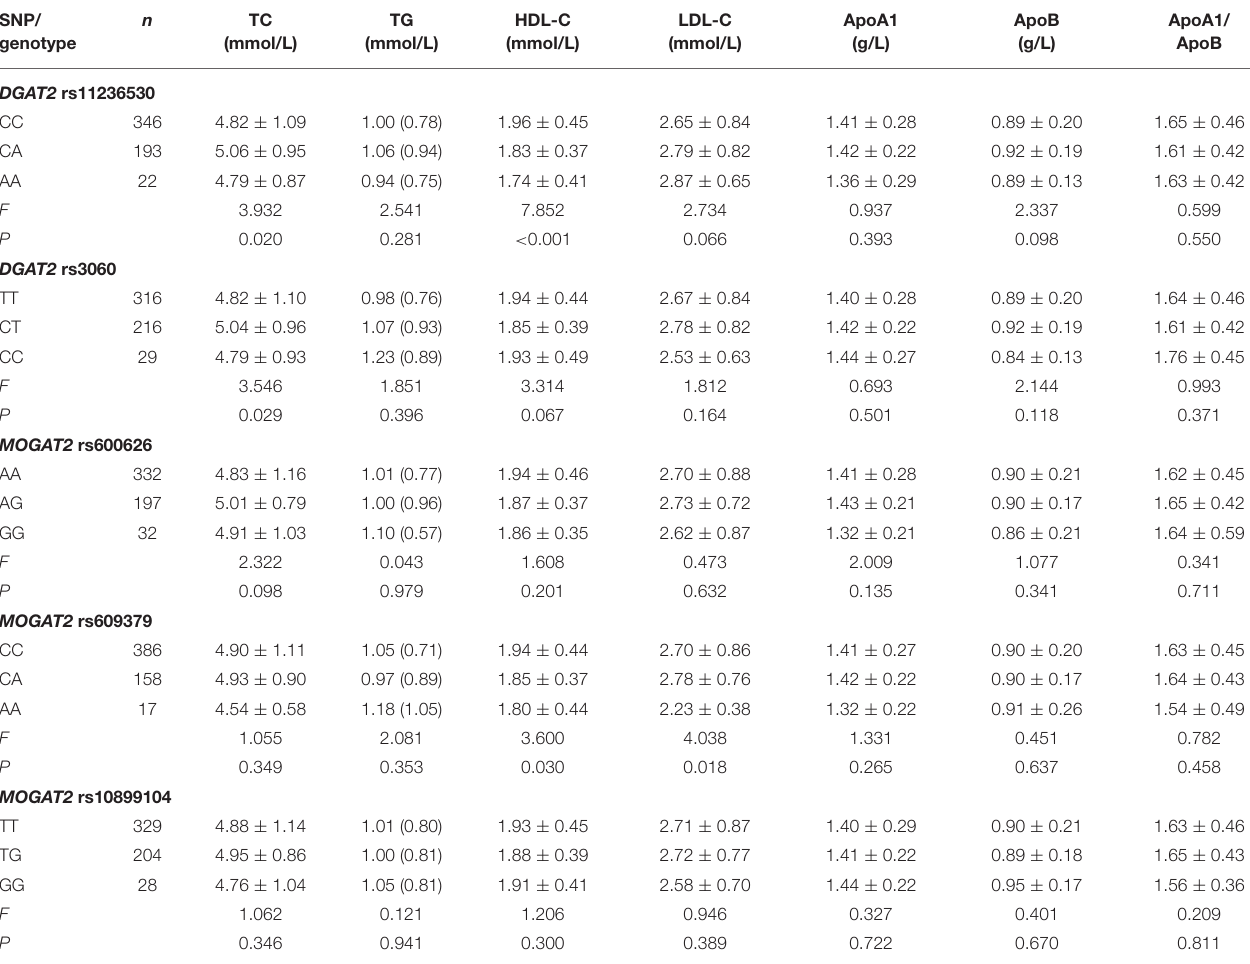
TABLE 5 | Genotypes of the 5 DGAT2-MOGAT2 SNPs and serum lipid levels in controls. SNP/